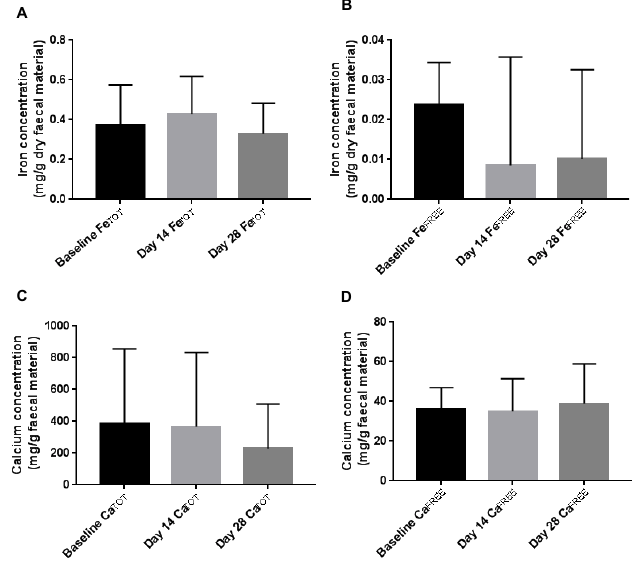
Figure 3. Faecal iron and calcium concentrations (per gram dry weight faecal material) at baseline, day 14 and day 28 of the intervention. ( A ) Total iron, ( B ) free iron, ( C ) total calcium and ( D ) free calcium. Mean values are plotted with error bars denoting standard deviations in the error. No statistical significance (using 1way ANOVA tests) was found between the data sets.